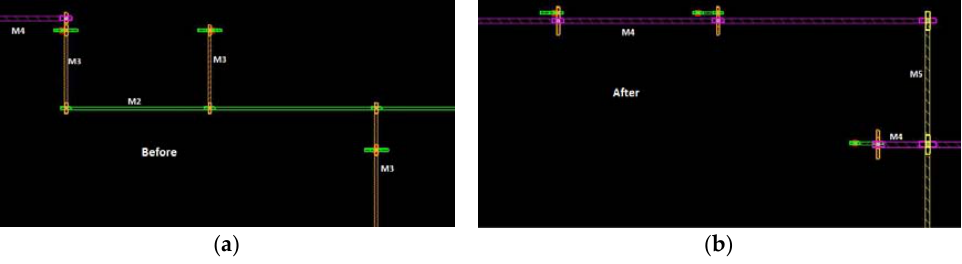
Figure 11. Net#1: detail wire used layers before ( a ) and after ( b ) optimization.